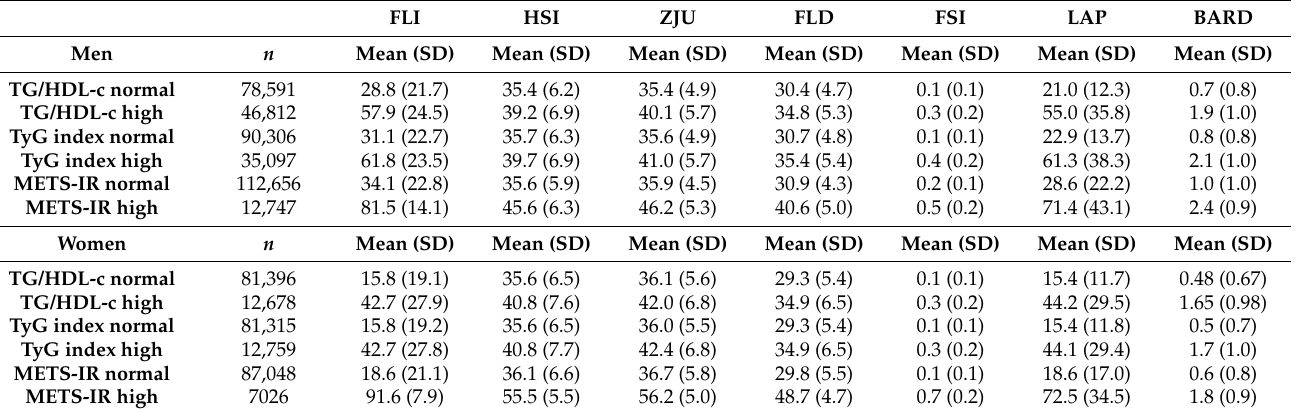
Table 2. Mean values of the different NAFLD and liver fibrosis risk scales according to values of insulin resistance risk scales. FLI HSI ZJU FLD FSI LAP BARD Men